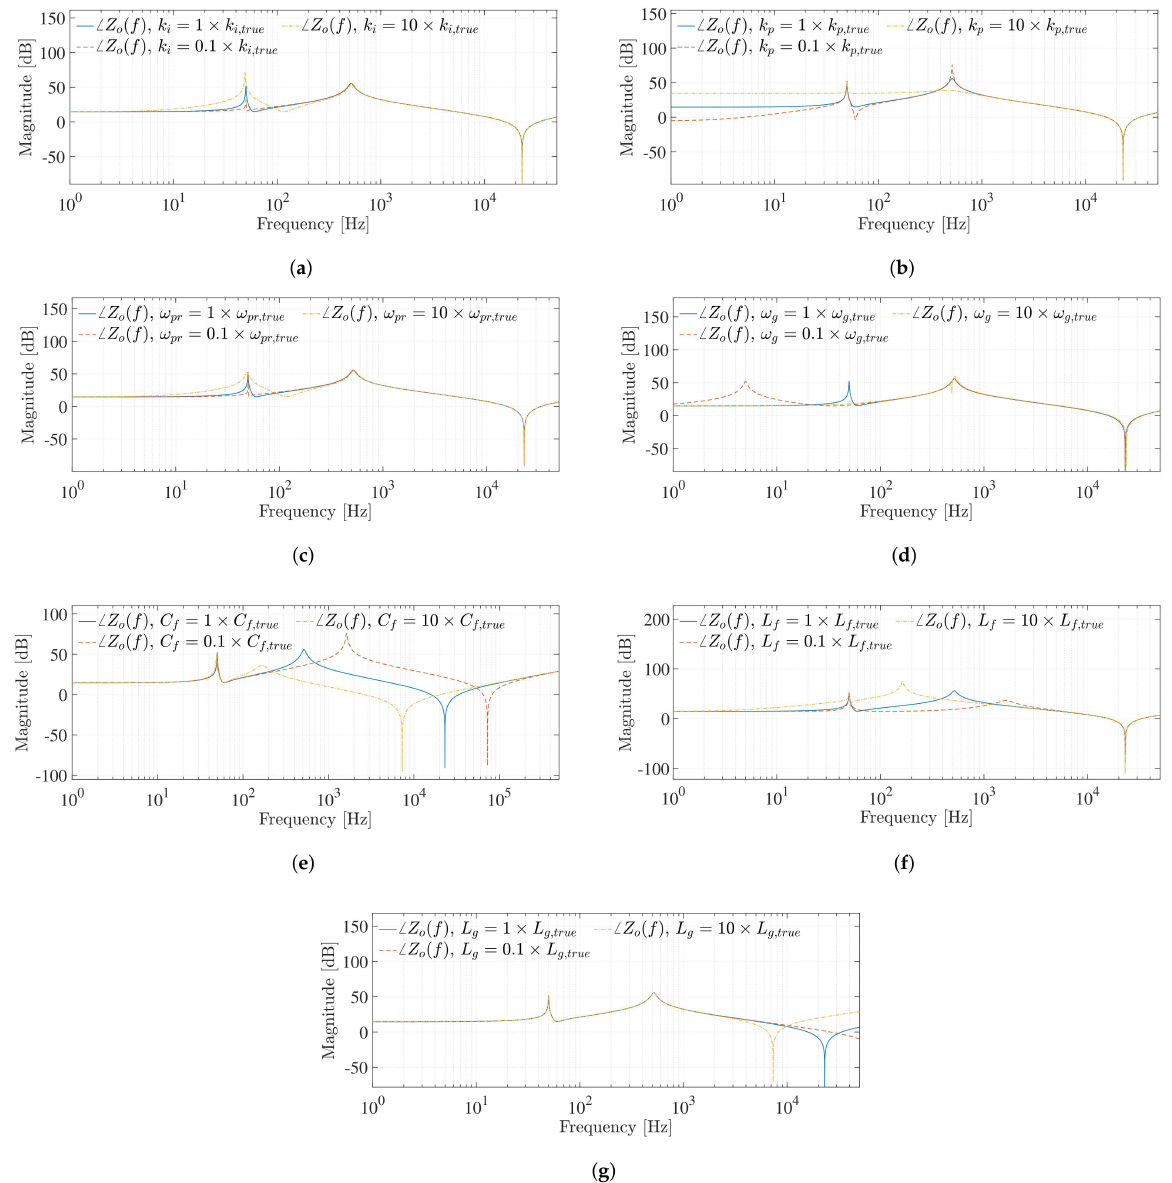
Figure 6. The magnitude and phase response of the analytical output impedance, Z o ( f ) , as a function